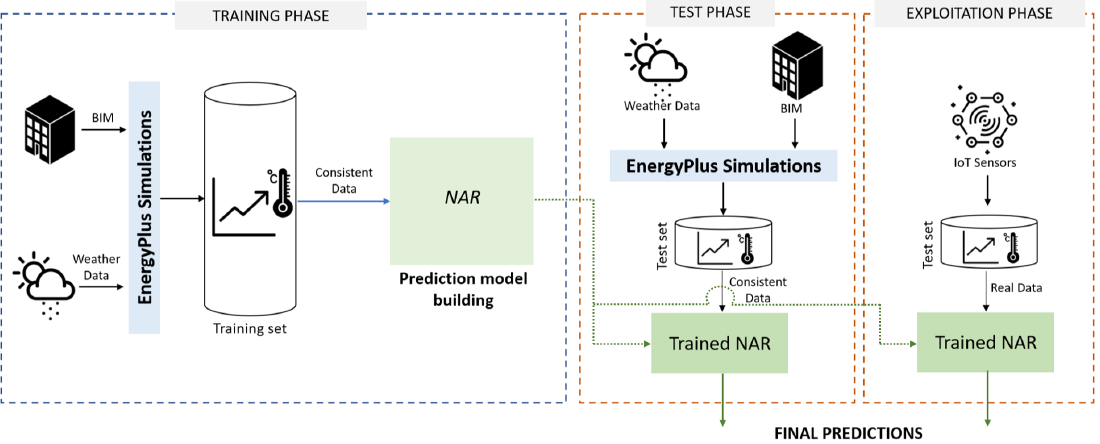
Figure 2. Main steps of the proposed